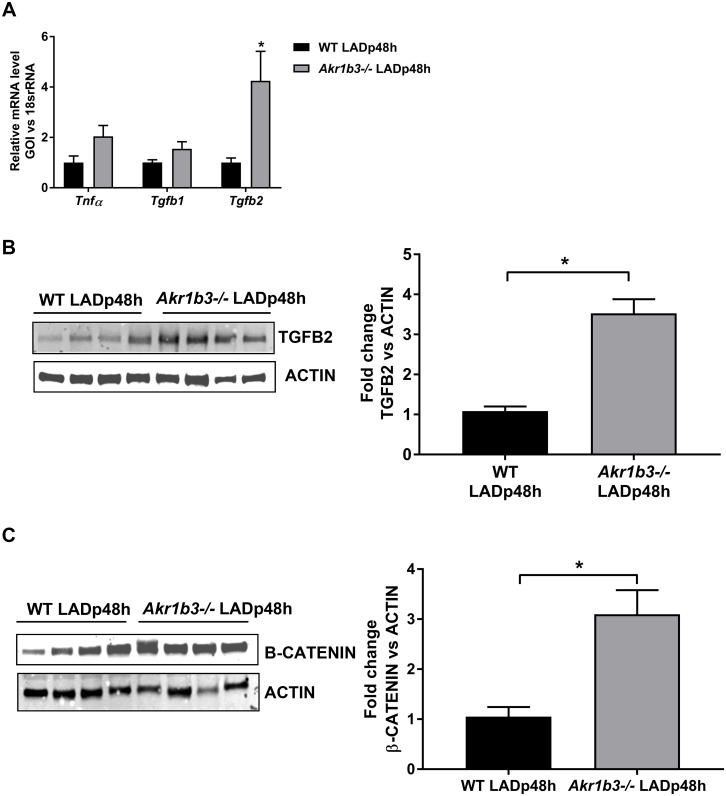
Upregulation of TGFβ2/β-catenin in Akr1b3 null mice 48 h post-I/R.(A) qRT-PCR on Tnfα, Tgfb1 and Tgfb2 transcripts from RNA isolated in the heart tissues, N = 5 mice/group. (B) Western blot of TGFB2 protein expression normalized to Beta-actin, N = 4 mice/group (C) Western blot of β-catenin protein expression normalized to Beta-actin, N = 4 mice/group. Error bars represent mean ± SEM. * p<0.05, unless otherwise noted.